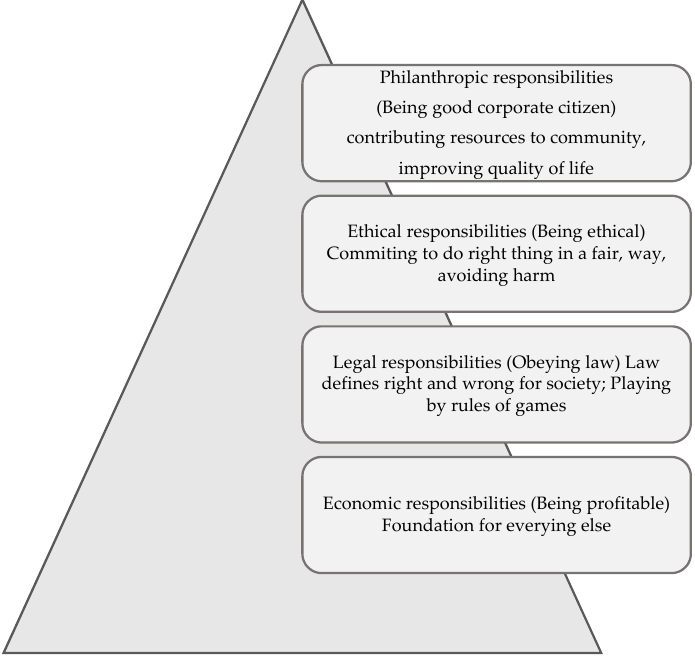
Figure 1. The pyramid of CSR.